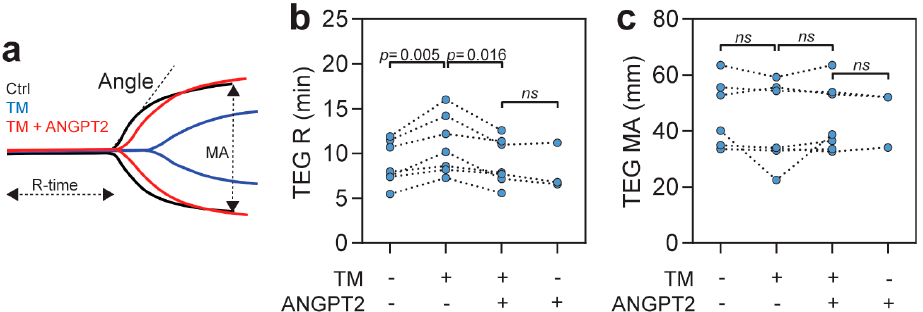
Figure 3. ( a ) TEG data from one of the donors showing sTM-dependent (blue) increase in reaction time (R) and decreased maximal amplitude (MA), which is inhibited by ANGPT2 (red); ( b , c ) TEG analysis of individual donor blood with 20 nM sTM) and 40 nM ANGPT2. Statistical comparison with repeated measures ANOVA with Bonferroni post hoc test. Additional TEG results can be found in Table 1. Table 1. TEG data from in vitro experiments.